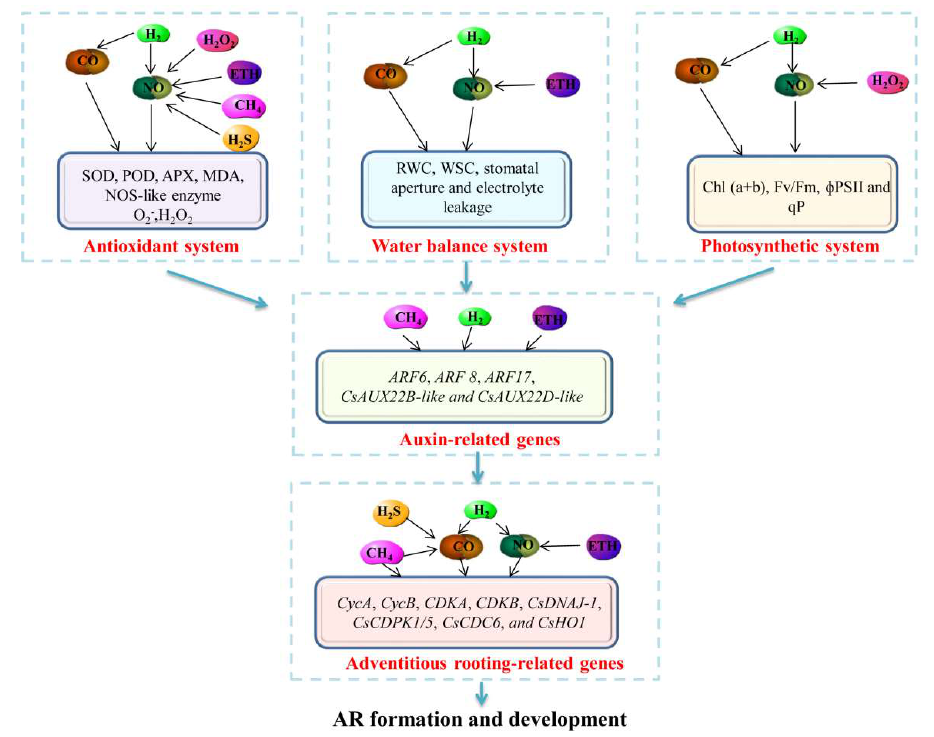
Figure 1. Schematic model of the interactions among di ff erent small signaling molecules during plant adventitious rooting through regulating di ff erent plant physiological process systems (antioxidant system, water balance system, and photosynthetic system). In the antioxidant system, NO is regarded as the downstream molecule to enhance the enzyme activities of SOD, POD, APX, and MDA and the production of O 2 − and H 2 O 2 [18,22,23,29,34]. In the water balance system, NO is also located downstream to increase RWC, WSC, stomatal aperture, and electrolyte leakage of plants [5,18,28]. In the photosynthetic system, NO is involved in H 2 , H 2 O 2 , and CO-increased chl (a + b), Fv / Fm, Φ PSII, and qP [16,18,22]. In addition, some auxin-related genes, including ARF6 , ARF8 , ARF17, CsAUX22B- like, and CsAUX22D- like, can be up-regulated by the application of CH 4 , H 2 , and ETH [40,47,64,67]. Furthermore, small signaling molecules up-regulate AR-related genes such as CycA , CycB , CDKA , CDKB , CsDNAJ-1 , CsCDPK1/5 , CsCDC6, and CsHO1 [7,10,17,39,40,47,62,64,65] and finally conduct the formation and development of adventitious roots.